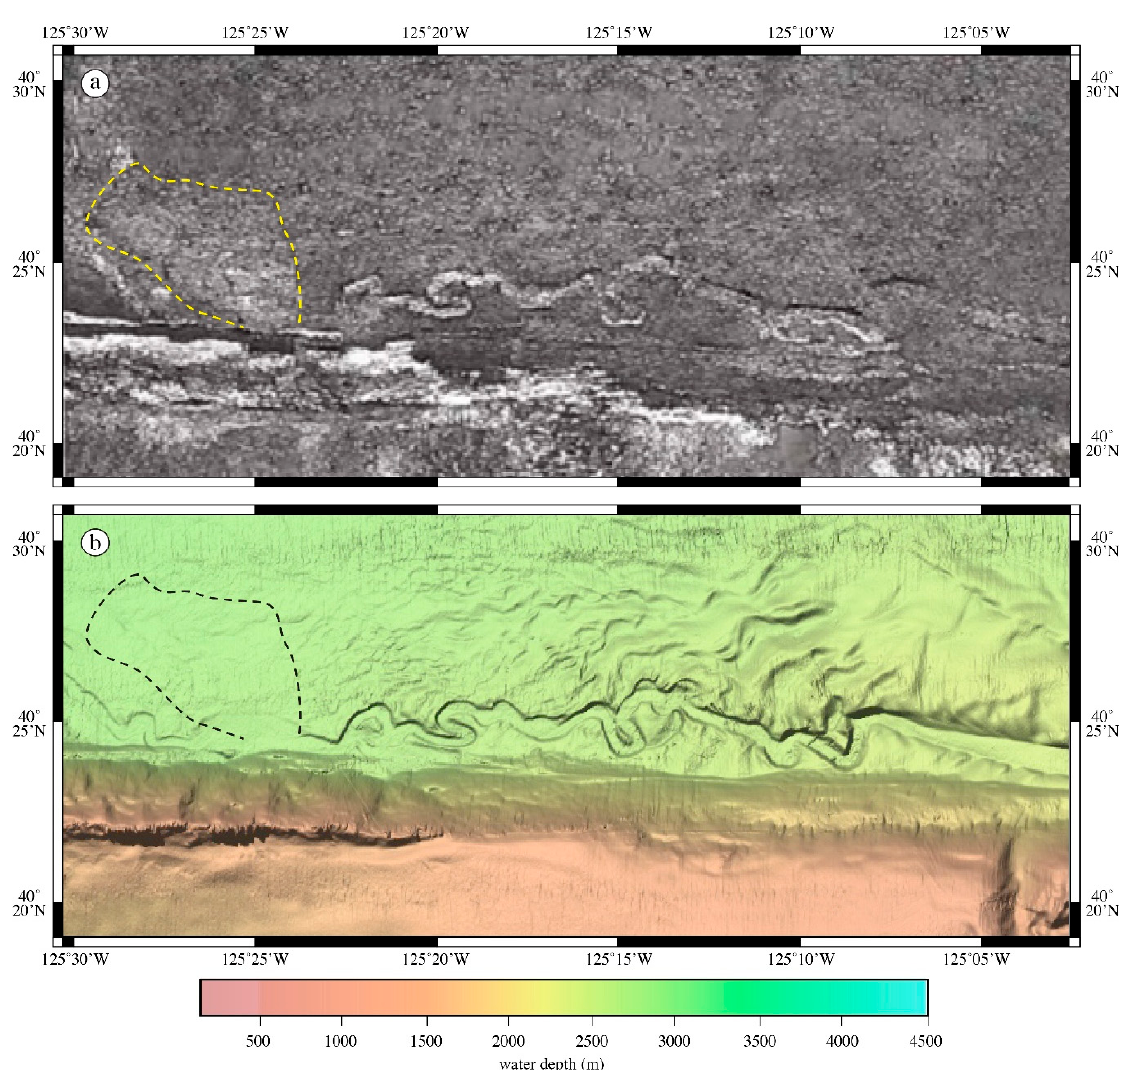
Figure 3. ( a ) GLORIA (6.5-kHz sidescan sonar) backscatter image of the eastern portion of Mendocino Channel, modified from [5]; ( b ) Multibeam bathymetry of same area. Dashed line (yellow and black) outline area of high 6.5-kHz backscatter in area immediately north of crevasse splay (see text for discussion). Location slightly larger than rectangle labeled “Fig. 10” on Figure 2.